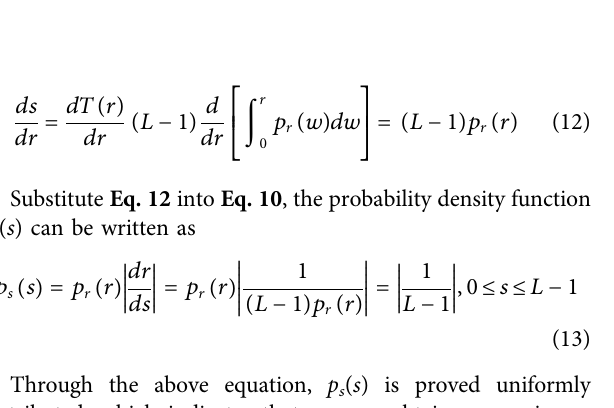
Frontiers in Bioengineering and Biotechnology |